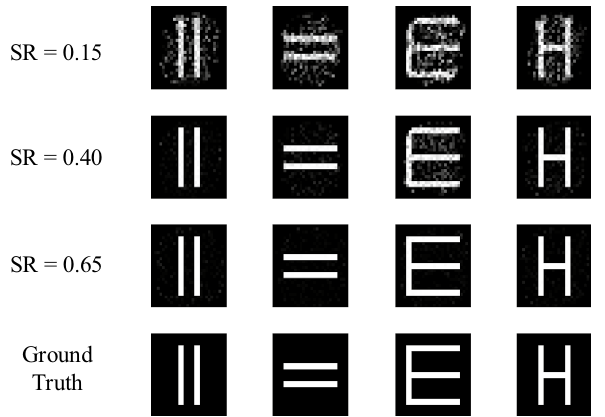
Figure 7. The test results of extensibility for the OGIMDF method under different SRs using the English letters and the double-seam